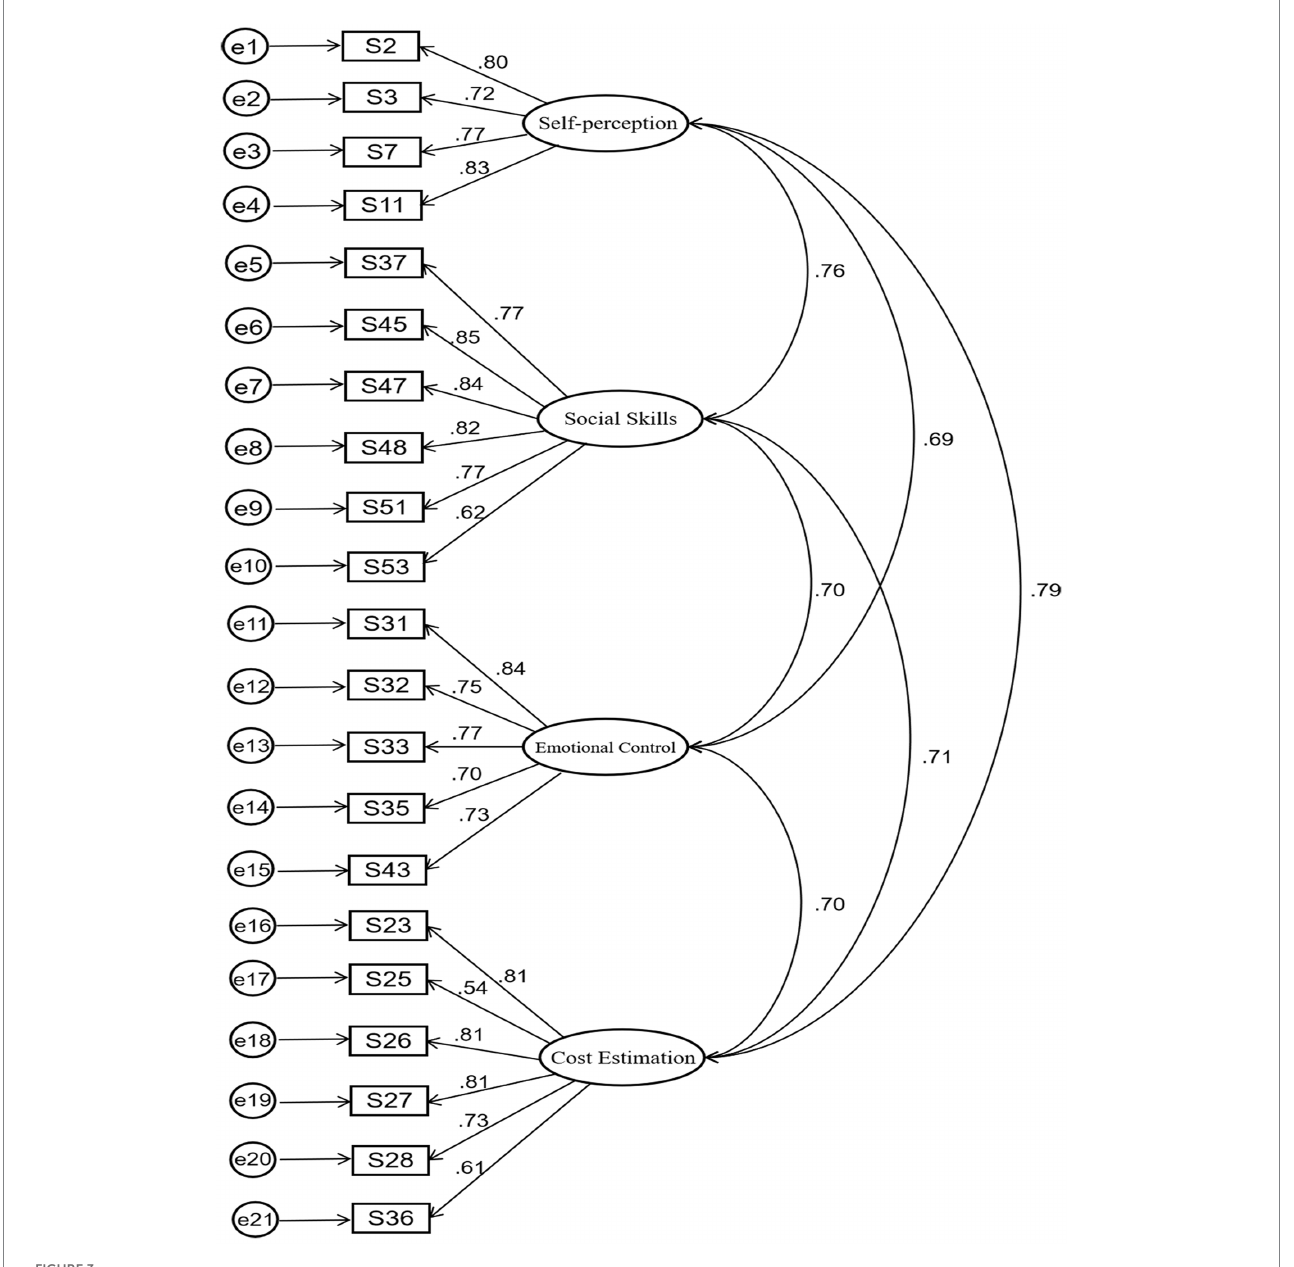
FIGURE 3 Confirmatory factor analysis for Model C.